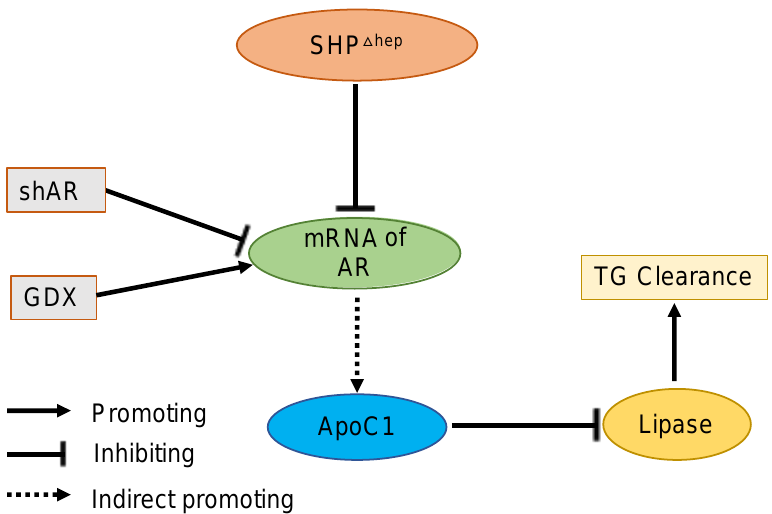
Figure 8. Graphic Model. Hepatic deletion of SHP (SHP ∆ hep ) leads to the downregulation of liver androgen receptor (AR) mRNA, decreased plasma ApoC1 protein levels, increased lipase activity, and increased triglyceride (TG) clearance. Reduction of liver AR mRNA by shRNA or androgen levels by gonadectomy (GDX) respectively decreases or increases ApoC1 protein levels and blunts the effect of hepatic deletion of SHP on blood TG levels.